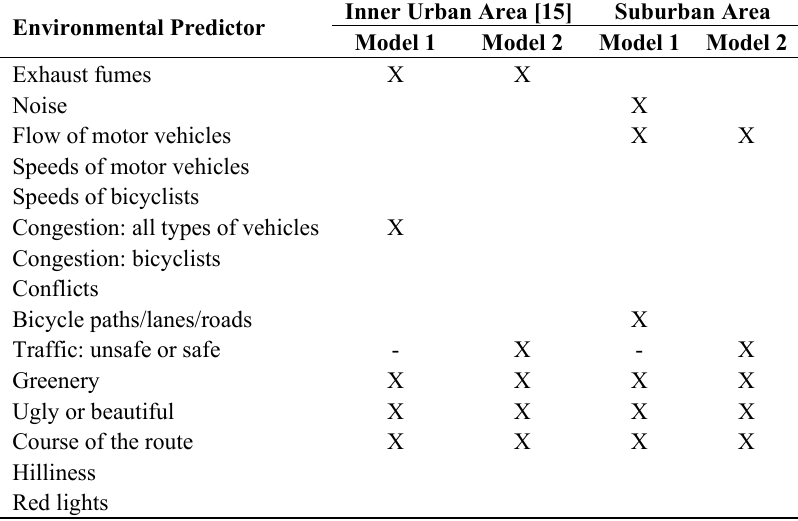
Table 9. Environmental predictors that contributed significantly to the variance of the outcome variable hinders or stimulates